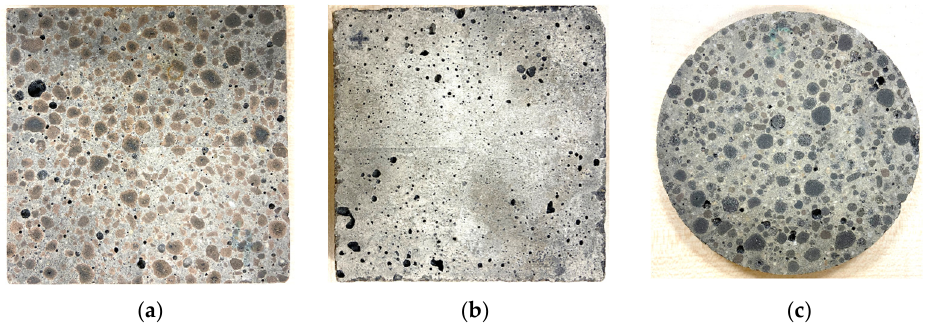
Figure 5. ( a ) Concrete sample type 1, cut side (after removing the coating); ( b ) concrete sample type 1, formwork side (after removing the coating); ( c ) concrete sample type 3 (after removing the coating).